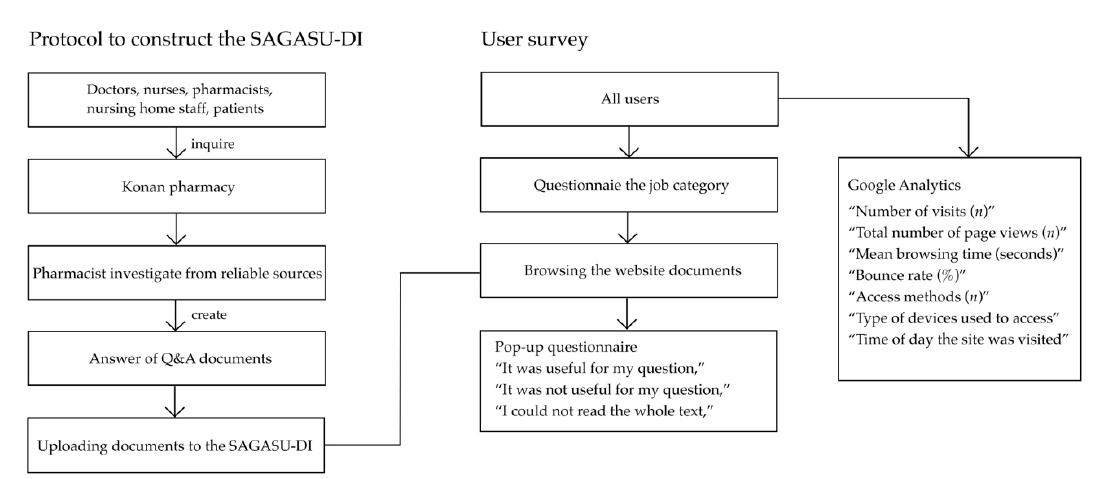
Figure 1. Protocol to construct the SAGASU-DI and flowchart of user survey.